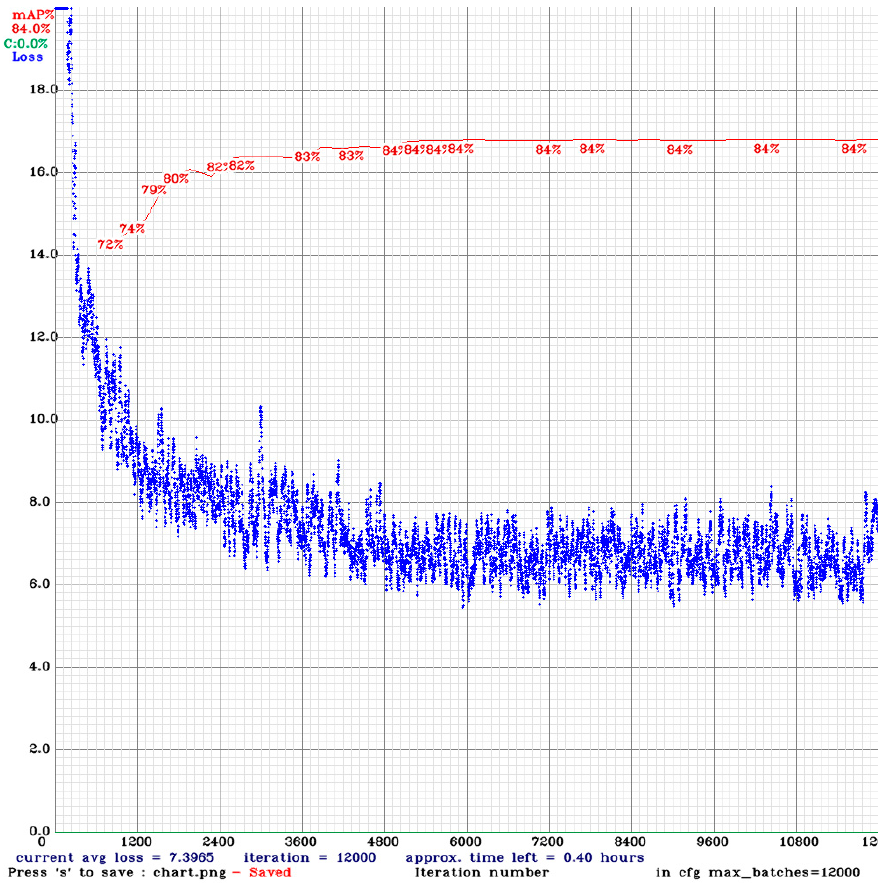
Figure 15. Training performance of datasets using the YOLOv4 algorithm.